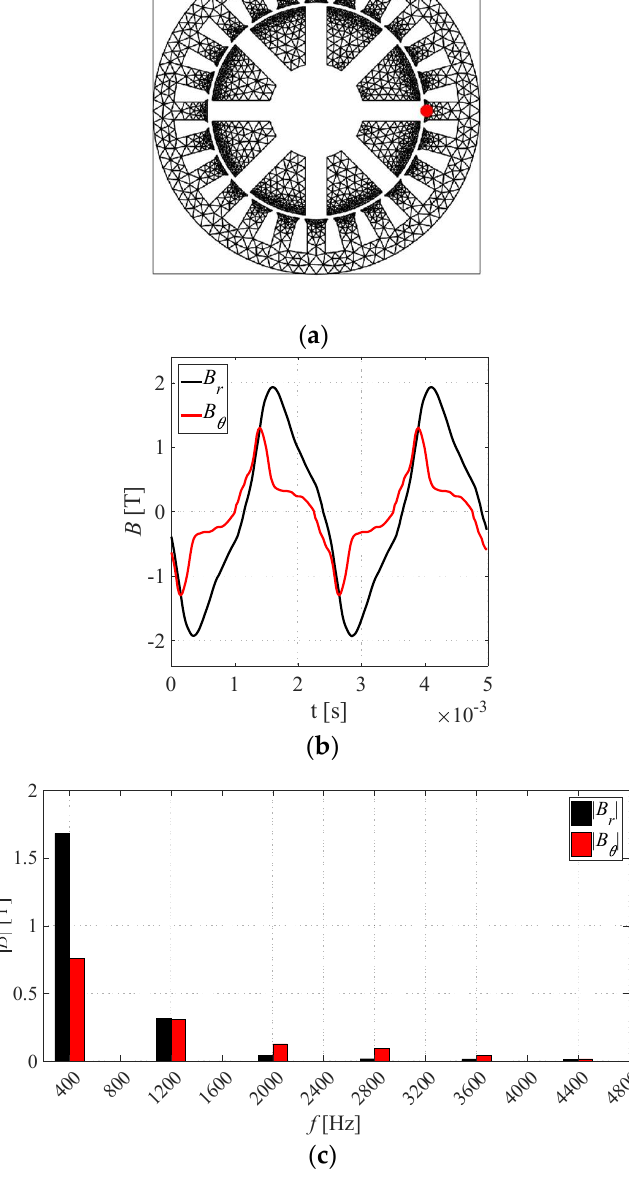
Figure 17. Steps for computation of losses density, example for element i (red dot). ( a ) Example of core geometry mesh, ( b ) waveform of flux density radial and tangential components in element i , ( c ) waveforms’ Fourier transformation.